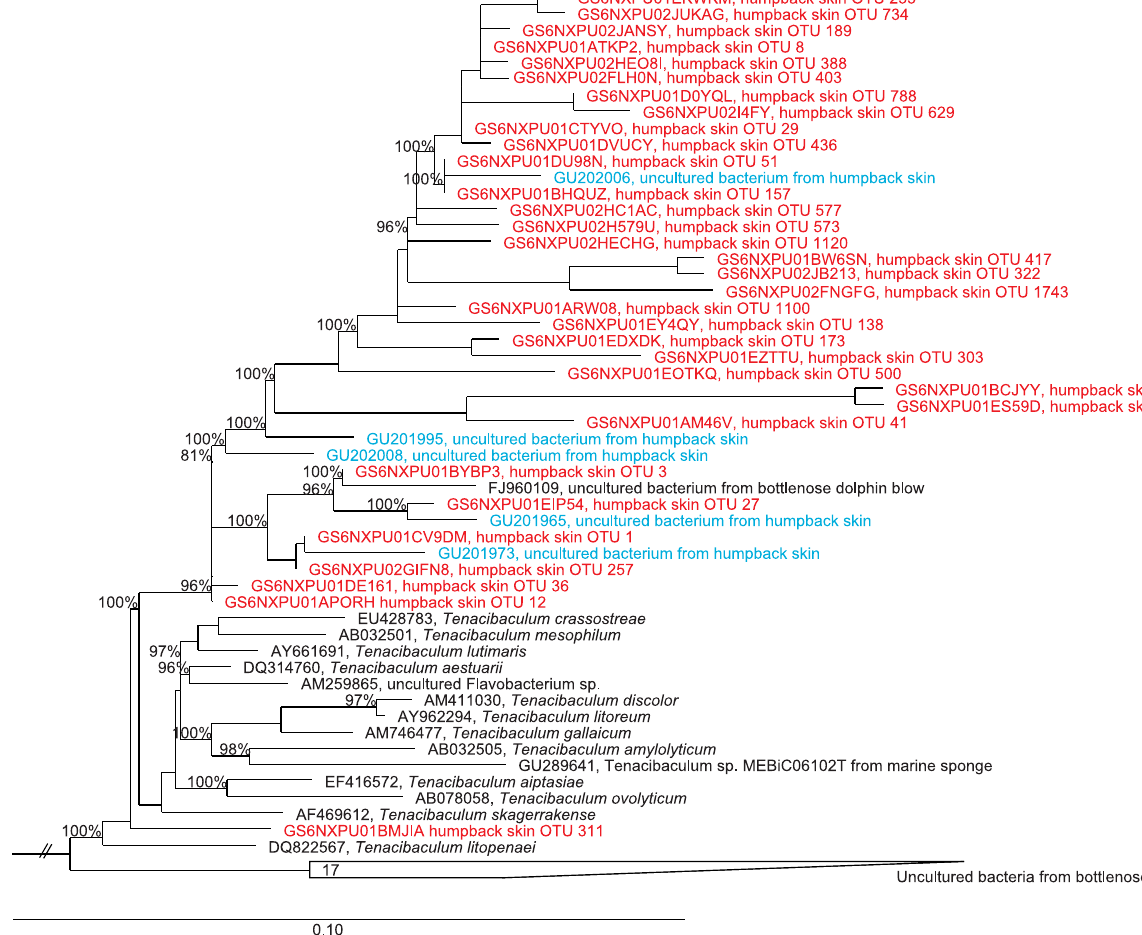
Figure 5. Phylogenetic relationship of Tenacibaculum -affiliated sequences. Represented SSU rRNA gene sequences include Tenacibaculum - affiliated sequences recovered from whale skin, cultivated Tenacibaculum isolates, and relatives within the Tenacibaculum lineage. Red sequences are short-reads from this study and blue are full-length sequences from a previous study on humpback whale skin [8]. The scale bar corresponds to 0.10 substitutions per nucleotide position, and only bootstrap values . 70 are listed. Sequences from Caldilinea aerophila (AB067647), Roseiflexus castenholzii (CP000804) and Actinomyces oris (GQ421308), were used to form the outgroup. Full accession numbers for the dolphin respiratory- bacteria sequences are available in [35].